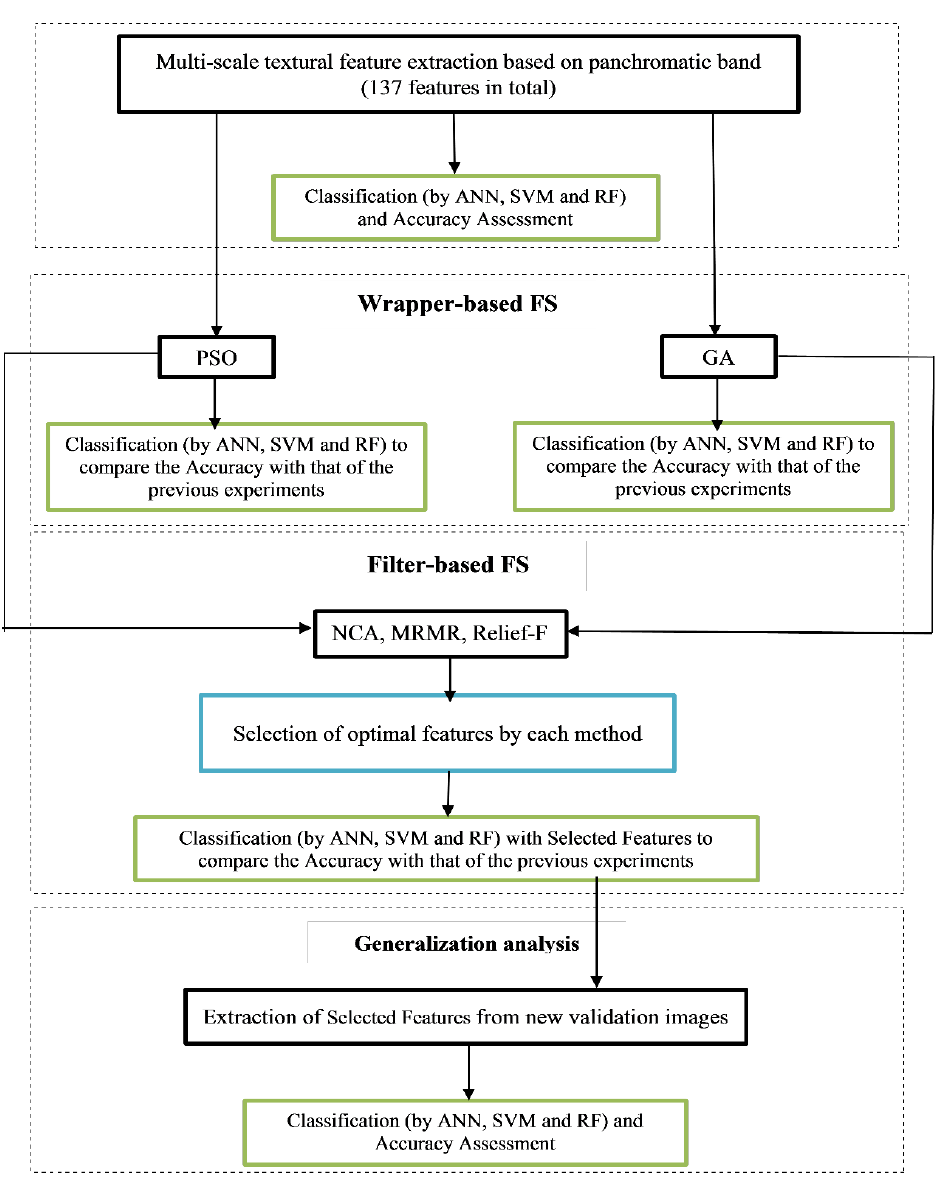
Figure 1. Workflow of optimum textural features selection for urban land use/cover classification.